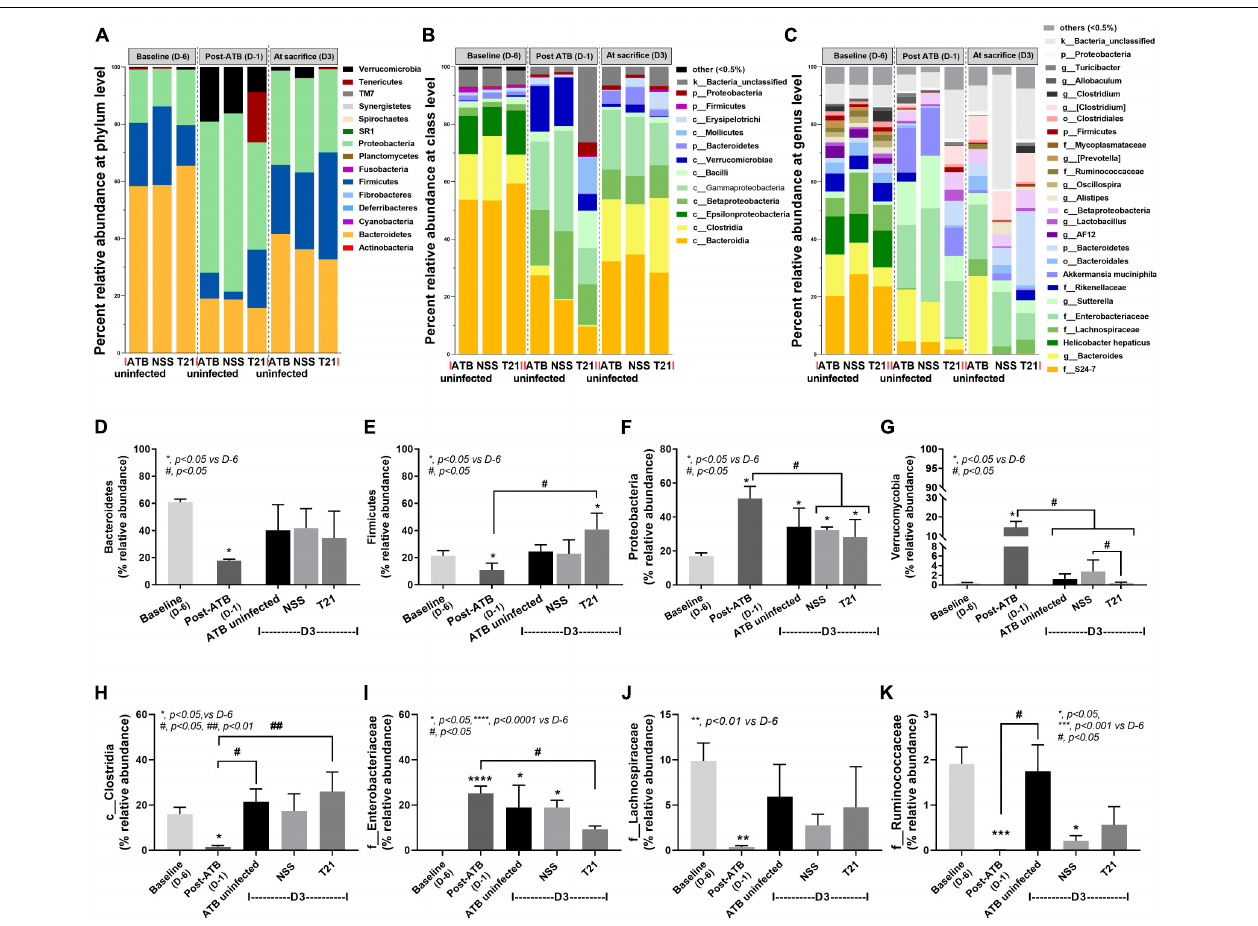
FIGURE 5 | Lacticaseibacillus casei T21 slightly attenuated gut dysbiosis in C. difficile -infected mice. Gut dysbiosis of the C. difficile infection (CDI) model was evaluated by fecal microbiome analysis of mice in the ATB uninfected, NSS, and T21 groups at multiple time points. The average relative abundances of microbiota at the phylum level (A) , class level (B) , and genus level (C) are demonstrated. The average relative abundances of individual taxon are shown: Bacteroidetes (D) , Firmicutes (E) , Proteobacteria (F) , Verrucomicrobia (G) , Clostridia (H) , Enterobacteriaceae (I) , Lachnospiraceae (J) , and Ruminococaceae (K) . Notably, data of